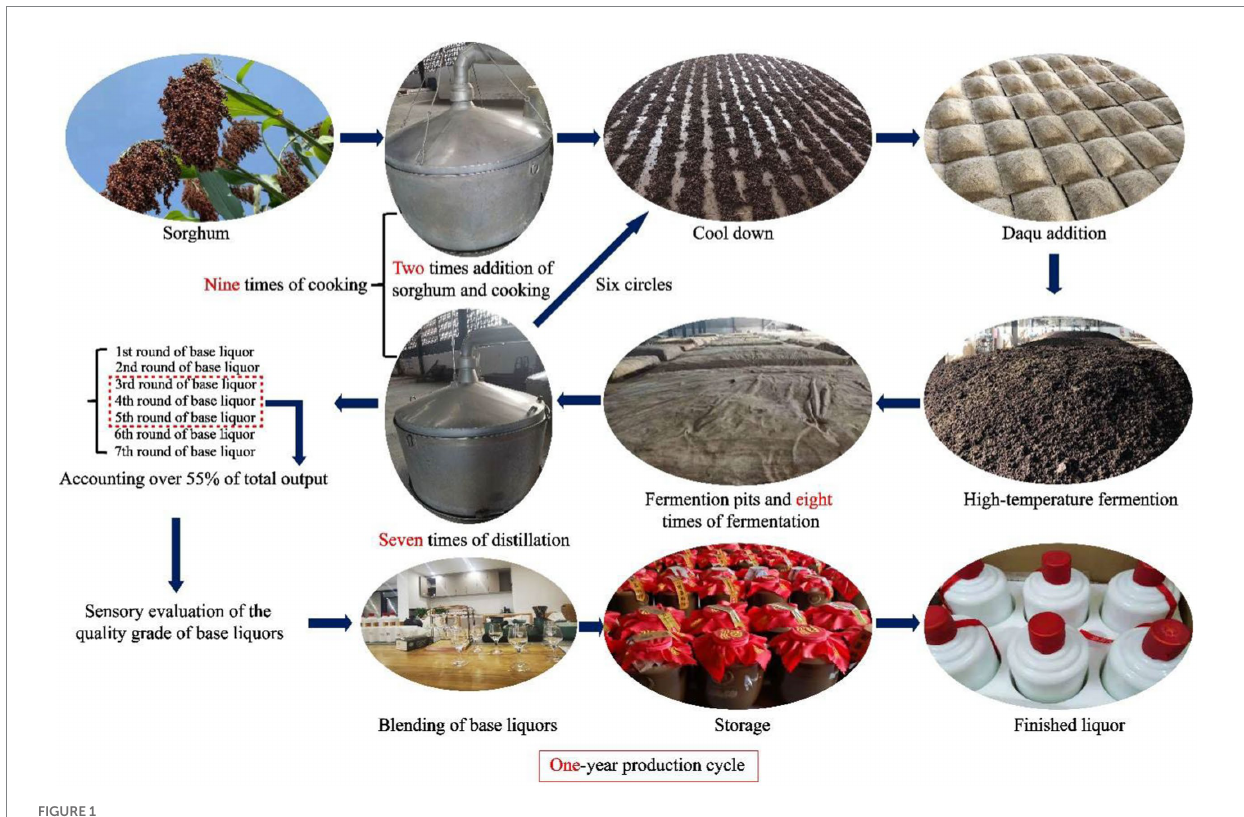
FIGURE 1 The main processes of soy sauce-aroma type